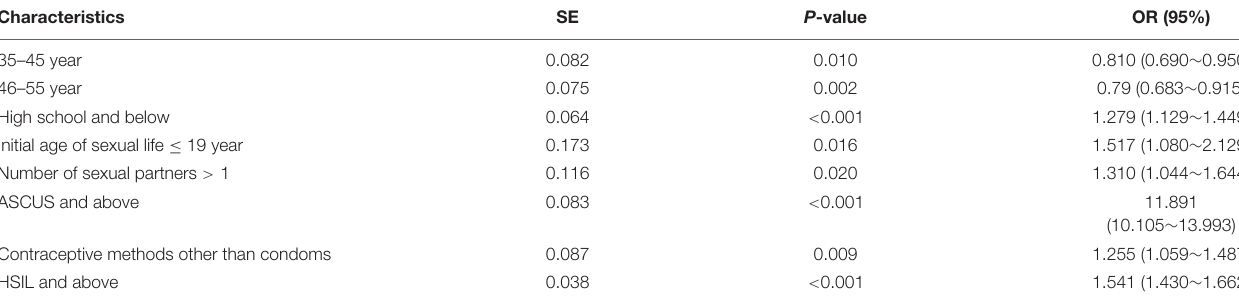
TABLE 11 | Multivariate analysis of risk factors affecting human papillomavirus (HPV) infection.